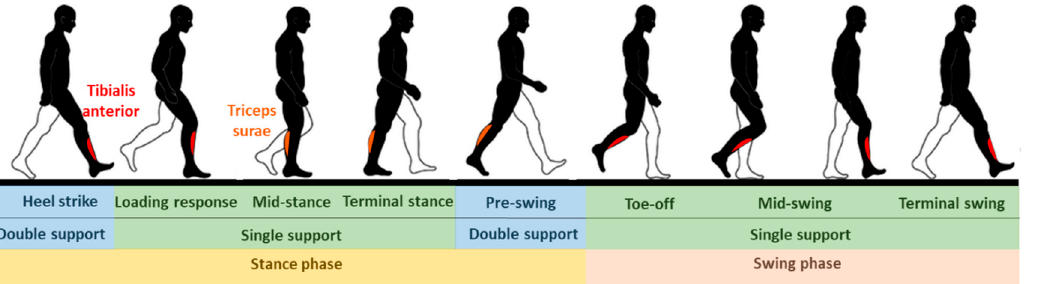
Figure 1. Gait cycle divisions and the activation of the ankle dorsiflexor (tibialis anterior shown in red color) and plantar flexor (triceps surae shown in orange color) muscles during each phase of the gait. Adapted with permission from ref. [16]. Copyright 2006